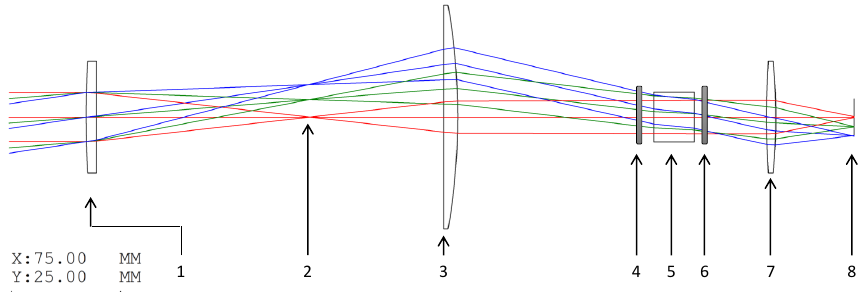
Figure 4. Ray tracing diagram of the telescopic lens system for ALI simulated by Code V optical design software. The elements in the system are the following: (1) 150mm focal length plano-convex lens, (2) field stop, (3) 100mm focal length plano-convex lens, (4) vertical linear polarizer, (5) Brimrose AOTF, (6) horizontal linear polarizer, (7) 50.4mm focal length biconvex lens, and (8) imaging plane.